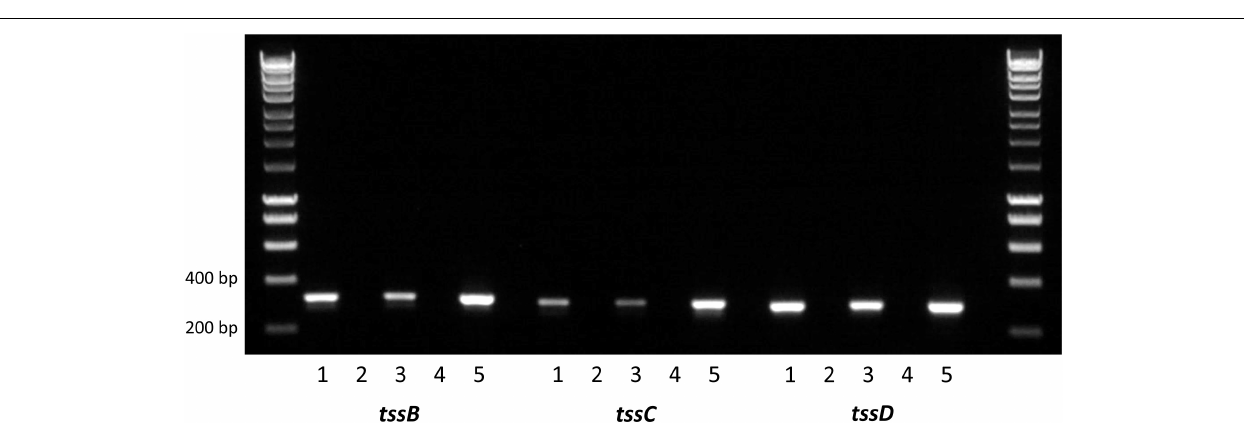
FIGURE 2 | Reverse transcription PCR analysis of T6SS gene expression in the 488 wild-type strain. RNA was isolated from 488 wild-type strain. Plate cultures were grown on blood agar plates and incubated for 24 h under microaerobic conditions. Broth cultures were grown in Brucella broth for 16 h at 37 ◦ C with shaking at 75 rpm under microaerobic conditions. Extracted RNA was converted to cDNA. RT-PCR was performed using tssB , tssC , and tssD primers. The first and last lanes are the molecular weight marker (HyperLadder 1 kb, Bioline, United Kingdom). Lane 1: 488 cDNA (plate culture); Lane 2: negative control (488 cDNA from plate culture synthesized without reverse transcriptase); Lane 3: 488 cDNA (broth culture); Lane 4: negative control (488 cDNA from broth culture synthesized without reverse transcriptase); and Lane 5: positive control (488 gDNA). Expected sizes are 316 bp ( tssB ), 300 bp ( tssC ), and 287 bp ( tssD